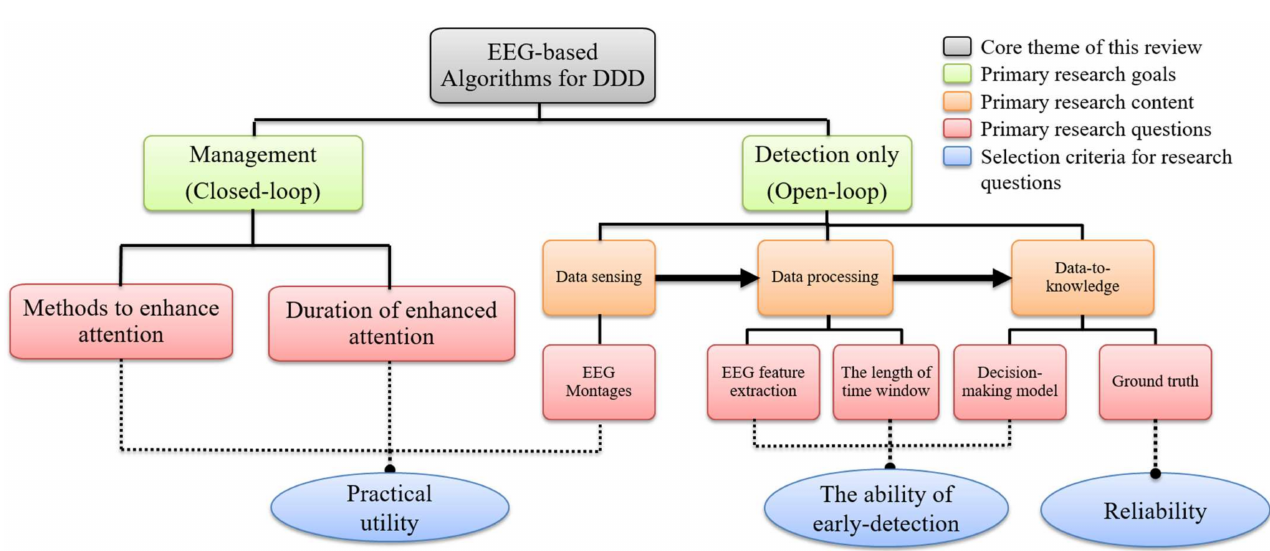
Figure 2. Hierarchical taxonomy for EEG-based DDD algorithms dealing with seven primary research questions and corresponding selection criteria for these